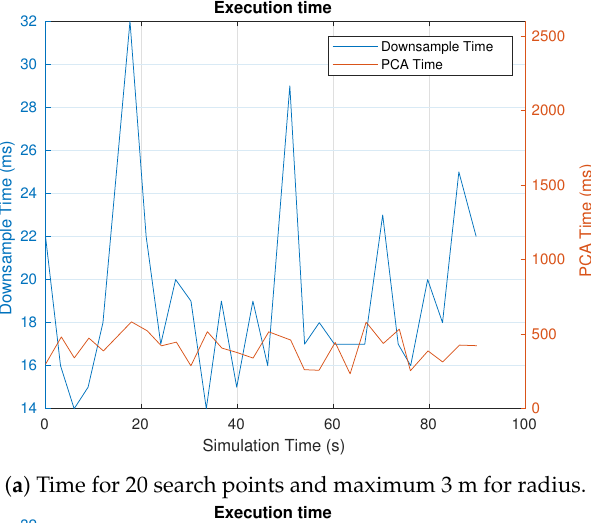
( a ) Time for 20 search points and maximum 3 m for radius. ( b ) Time for 30 search points and maximum 3 m for radius.